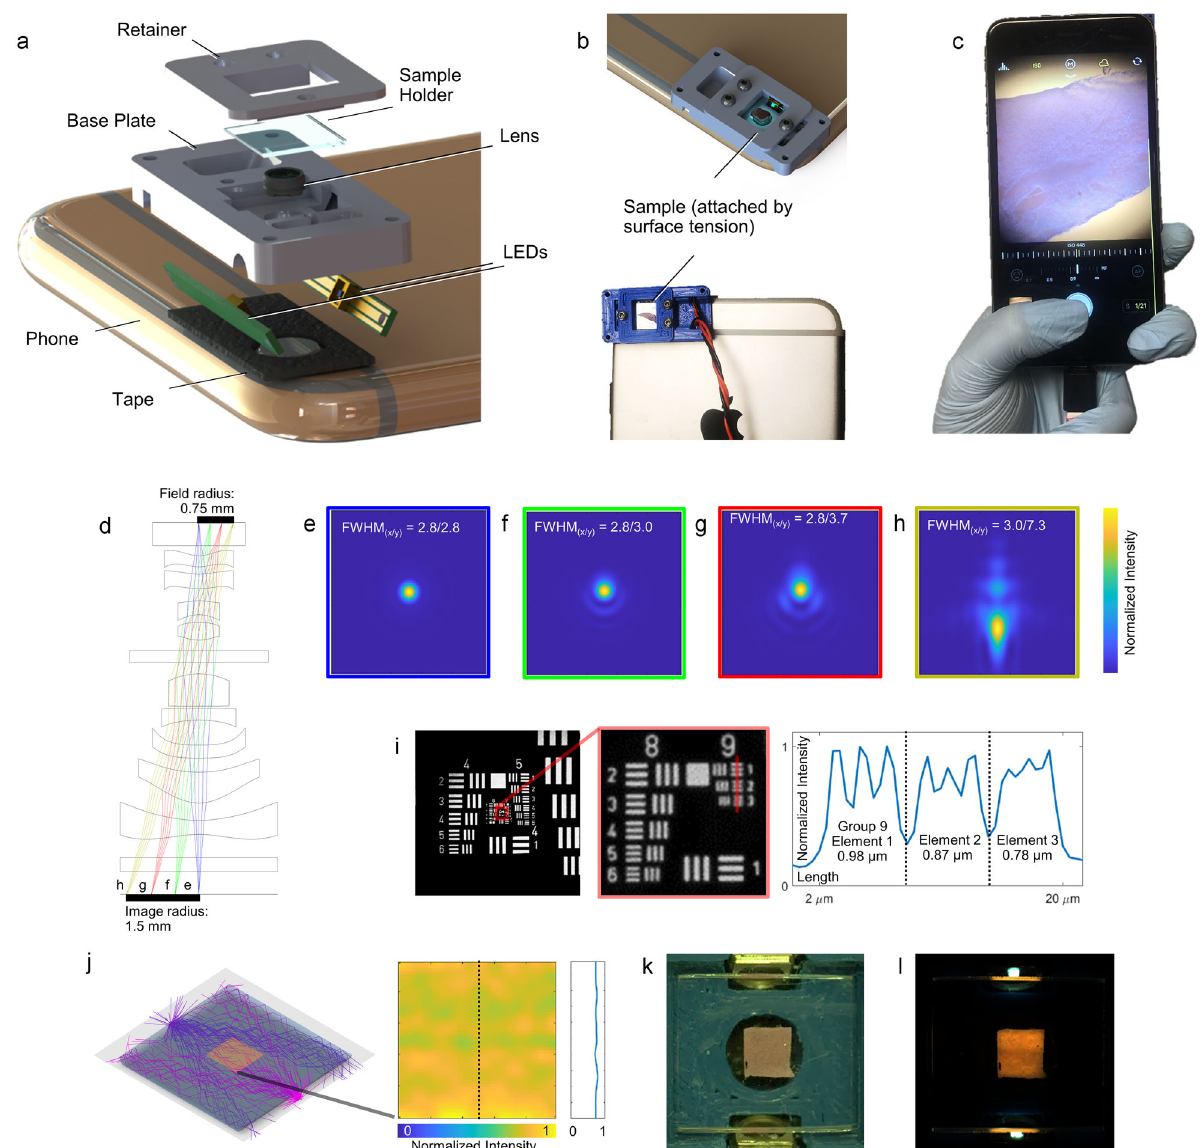
Fig. 1 Design, simulation, and characterization of Pocket MUSE. a Exploded schematic showing the major components of Pocket MUSE. b 3D rendering and photographs showing samples attached to the microscope through surface tension. c Photograph demonstrating the hand-held operation of Pocket MUSE. d Optical simulation of a small RACL (US7643225B1, f-number = 2.45) stacked on top of a smartphone camera lens (US20130021680A1, f- number = 2.46), showing ~2× magni fi cation (1.5 mm/0.75 mm). e – h Simulated Huygens point spread function (PSF) at the image plane showing the full width at half maximum (FWHM) spot diameter ( e ) Δ y = 0, ( f ) 0.25, ( g ) 0.5 and ( h ) 0.75 mm from the center of the fi eld (simulation FOV: 36.42 × 36.42 µ m 2 ). Minimal distortion to the PSF was observed within the center 1 mm diameter FOV. The simulation does not re fl ect the practical optical resolution of Pocket MUSE, which is higher due to smaller f-numbers (larger NAs). i Image of a USAF-1951 resolution target acquired with a 1/7 ″ RACL (Largan 40069A1) attached to an iPhone 6s + , showing resolving power up to Group 9 Element 2 (0.87 µ m) based on the Sparrow criterion. The middle image is a close-up view of the region in the red box in the original image. The plot on the right represents the normalized intensity pro fi le at the location of the vertical red line. Additional characterization at different locations of the FOV is shown in Supplementary Fig. 4. j Ray tracing simulation of the dual-LED frustrated TIR setup, showing relatively uniform illumination achieved in a 2.5 × 2.5 mm 2 region at the center of the sample holder. The heat map in the middle indicates the normalized intensity of the square. The plot on the right represents the normalized intensity pro fi le labeled with the vertical line. Intensity variation is within 10% across 3 mm FOV. k Bright- fi eld macro image showing a 2.5 × 2.5 mm 2 fl uorescent phantom on the Pocket MUSE sample holder. l A relatively uniform excitation pattern was achieved with the frustrated TIR illumination con fi guration, matching the simulation